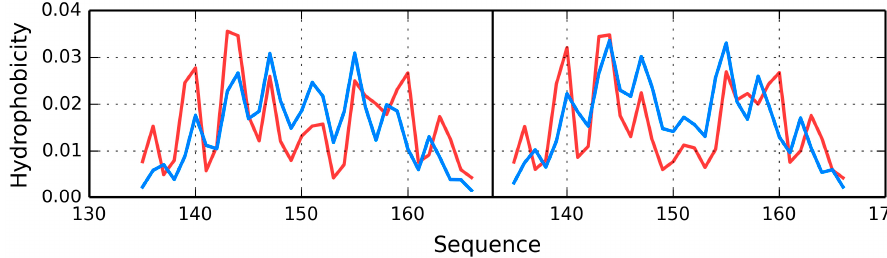
Figure 13. Utrophin-Theoretical ( blue line ) and observed ( red line ) hydrophobicity density profiles. The similarity between both distributions is evident.